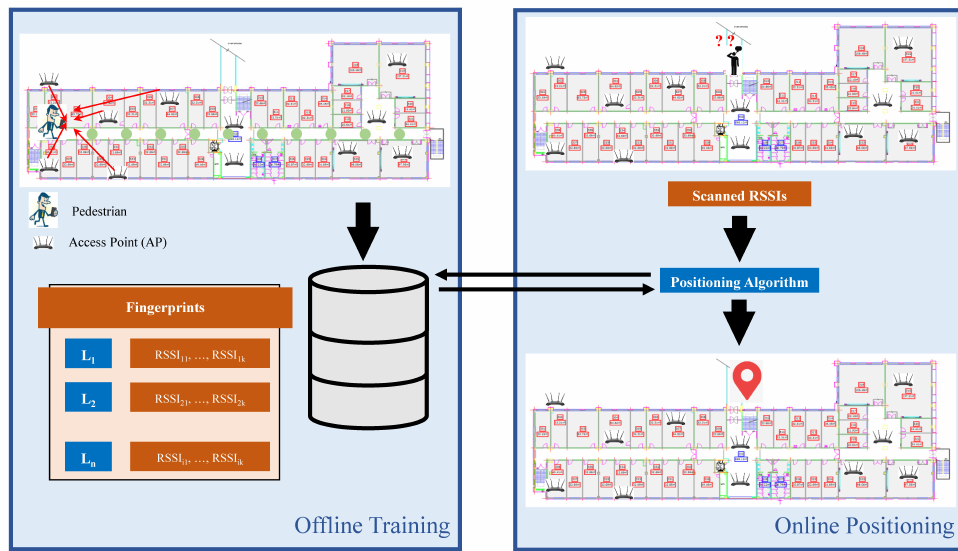
Figure 2. Architecture of a Wi-Fi based indoor positioning system that is based on fingerprinting